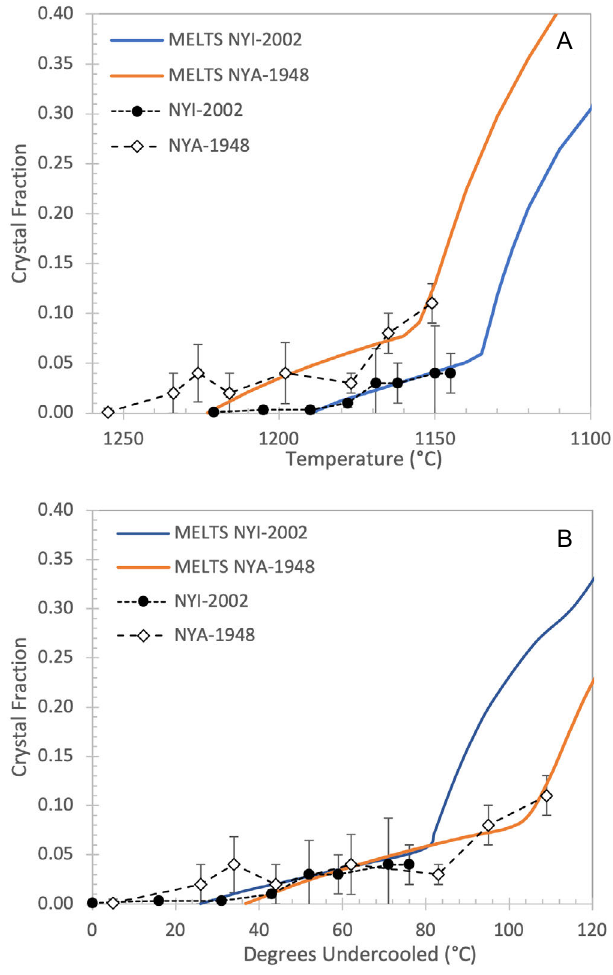
Figure 11: Crystallization histories for Nyiragongo (cir- cles) and Nyamuragira (diamonds). The colored lines are the data calculated for NYI-2002 (blue), and NYA- 1948 (orange) bulk material using the Rhyolite-MELTS program [Gualda et al. 2012]. Curves are constructed assuming an internally bu ff ered f O of − 0 . 63 and +0 . 75 2 NNO for Nyiragongo and Nyamuragira